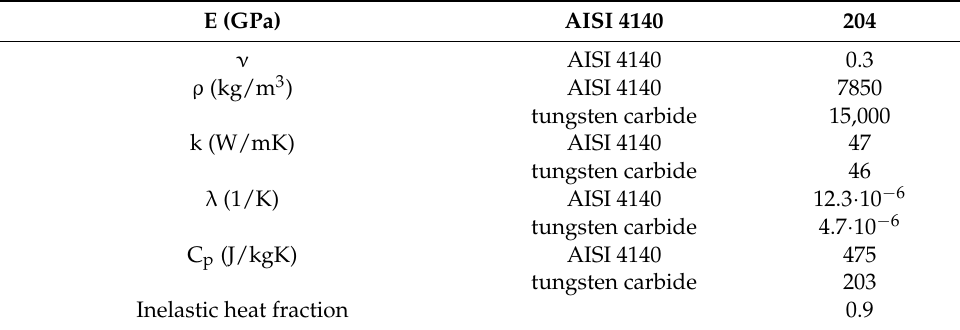
Table 3. Physical and mechanical properties of workpiece and tool